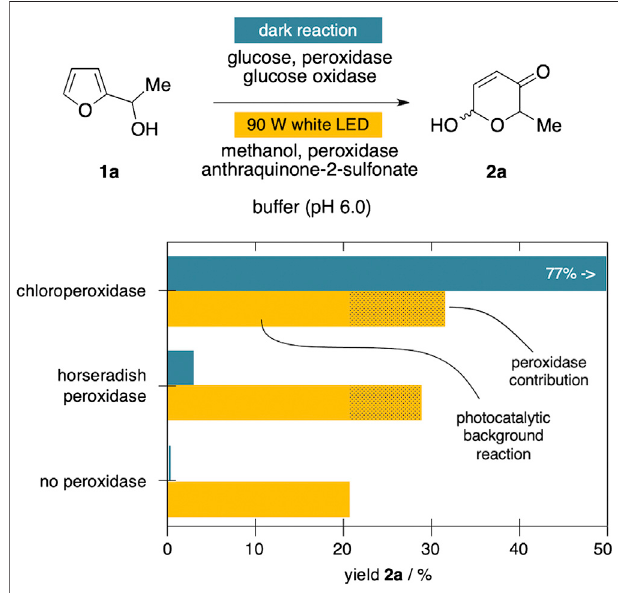
Frontiers in Chemistry |